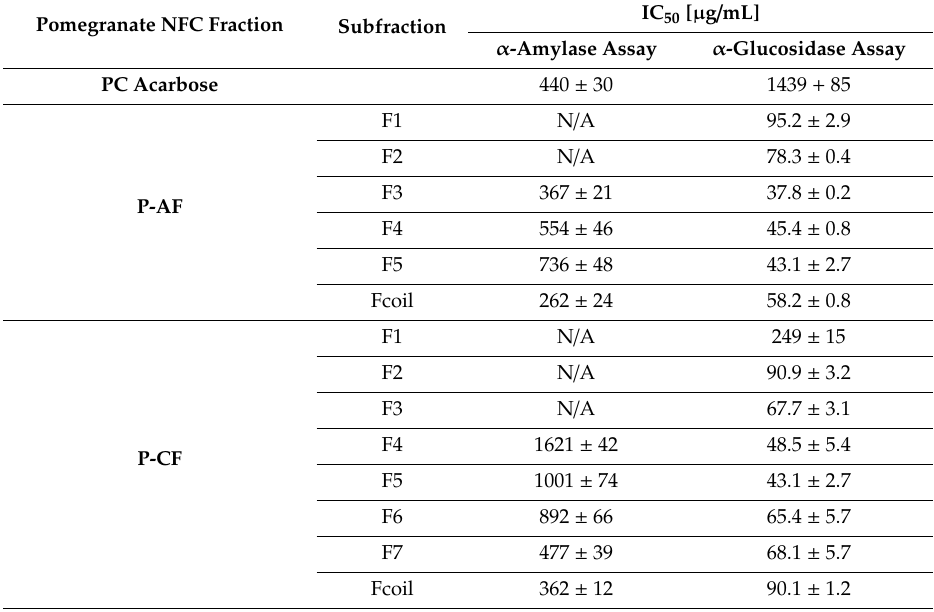
Figure 12. Inhibitory activities (IC 50 values in µ g / mL) of the subfractions of pomegranate NFC anthocyanin fraction (P-AF) and pomegranate NFC copigment fraction (P-CF) in comparison to the positive control (PC) acarbose. Results are presented as means ± SD ( n = 3). ( a ) P-AF α -amylase assay (F1, F2: N/A), ( b ) P-CF α -amylase assay (F1, F2, F3: N/A), ( c ) P-AF α -glucosidase assay, and ( d ) P-CF α -glucosidase assay. N/A = not available. Table 5. Inhibitory activities (IC 50 values) of the subfractions of pomegranate NFC anthocyanin fraction (P-AF) and pomegranate NFC copigment fraction (P-CF) Results are presented as means ± SD ( n = 3). N/A = not available.